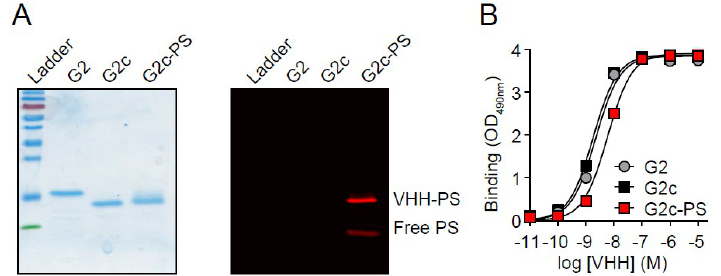
Figure 4. Conjugation of G2c to photosensitizer IRDye700DX. ( A left ) Reducing SDS-PAGE gel showing purified G2 from Escherichia coli , G2c from Saccharomyces cerevisiae , and G2c-PS . Size-separated proteins were stained with PageBlue stain. ( A right ) G2c-PS and free PS in the gel shown on the left, as detected with an Odyssey scanner before the PageBlue stain. ( B ) Binding of G2, G2c, and G2c-PS to Met ectodomain in ELISA (representative figure, mean ±